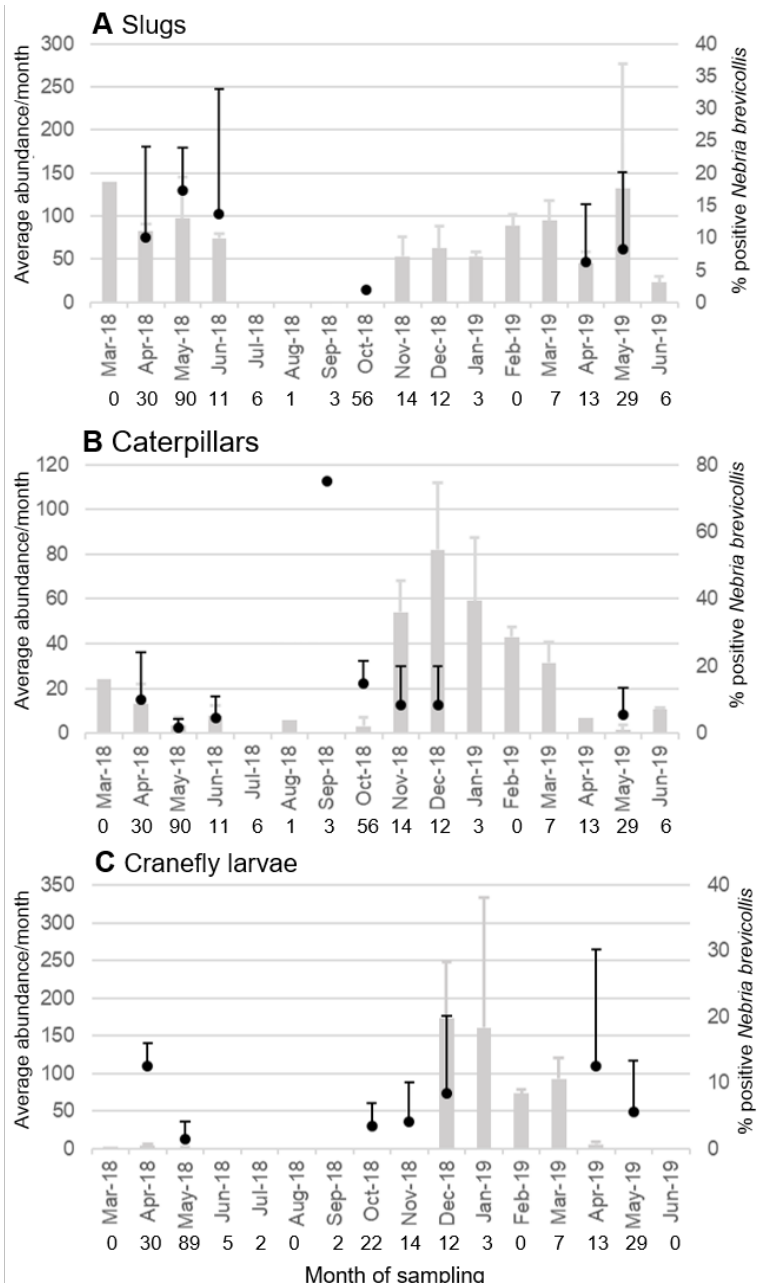
Figure 4. Seasonal change in the feeding incidences on the three pest groups by Nebria brevicollis . Average number + standard deviation (SD) of slugs ( A ), caterpillars ( B ) and cranefly larvae ( C ) collected per month (grey columns) and average percentage + SD of Nebria brevicollis that tested positive for the corresponding pest group (black dots). The numbers underneath the sampling months indicate the total number of N. brevicollis tested in each month.